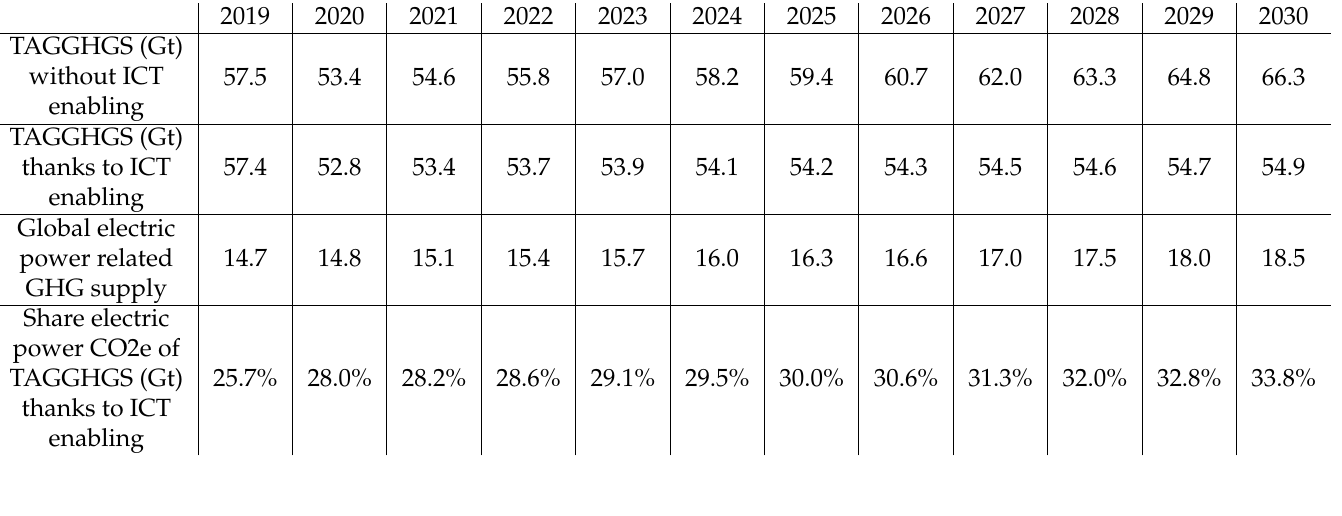
Table 16. Estimation of global GHG supply (Gigatonnes) with and without ICT handprint and Share of electric power GHG, 2019-2030.